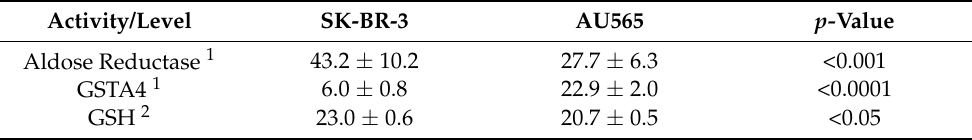
Figure 3. HNE–protein adducts in SK-BR-3 and AU565 cells with and without Rlip-LNA and AA. Concentration of HNE–protein adducts was determined by ELISA using protein samples from each treatment group as described in Materials and Methods. (A) Basal HNE–protein adducts were significantly higher in AU565 cells ((* p < 0.05, *** p < 0.001) than in SK-BR-3 cells. ( B ) 4-HNE was quantified by the OxiSelect ELISA assay that uses antibodies against 4-HNE–protein adducts. Cells growing in the log phase were treated with either Rlip-LNA or corresponding scrambled control LNA (10 µg/mL in 0.4% Lipofectamine) for 24 h prior to assay. Rlip depletion significantly ( p < 0.001) increased 4-HNE in both cell lines. 4-HNE was increased significantly over control after treatment with either 50 or 100 µM AA in SK-BR-3 ( p < 0.001, n = 3 independent measurements with 8 replicates each). AA actually reduced 4-HNE in AU565 ( p < 0.05), but 100 µM caused a small increase ( p < 0.05). ( C ) The effect of Rlip depletion by Rlip-LNA was visualized by Western blots against 4-HNE–protein adduct antibodies on total cell lysates, returning similar qualitative results compared with the ELISA assay. ( D ) Western blots are shown to visualize differences in antigenic levels of GSTA4, AR and ALDH1 (using ALDH1L1 antibodies cross-reactive with ALDH1). All Western blots shown are representative of results from three separate experiments. Uncropped Western blots figures are shown in Figure S2. Table 1. AR activity, GSTA4 enzyme activity and GSH content in SK-BR-3 and AU565 cells. AR activity was significantly higher in SK-BR-3 cells, and 4-HNE conjugation activity was significantly higher in AU565 cells, as calculated by an unpaired two-tailed Student t -test. GSH content was similar in both cell lines.